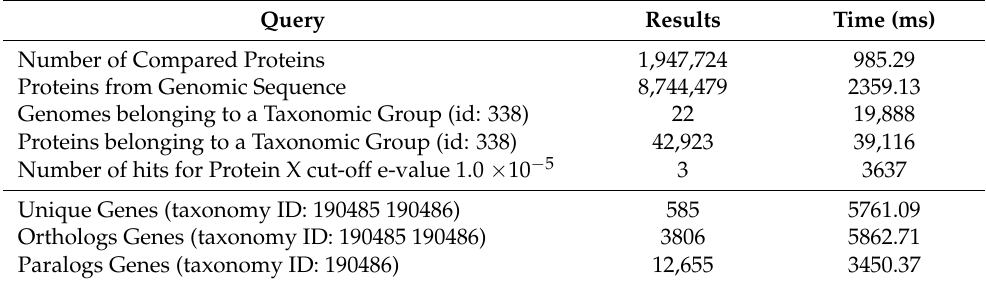
Table 2. Experimental